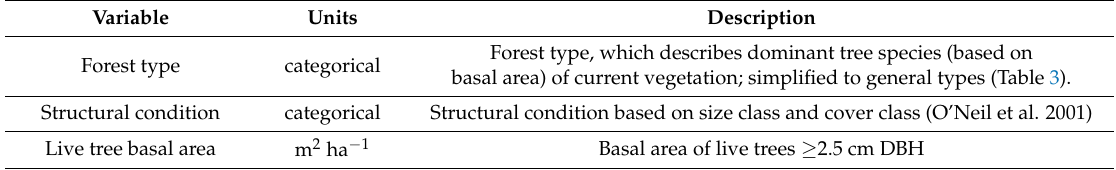
Table 2. Gradient nearest-neighbor (GNN) variables included in spatial